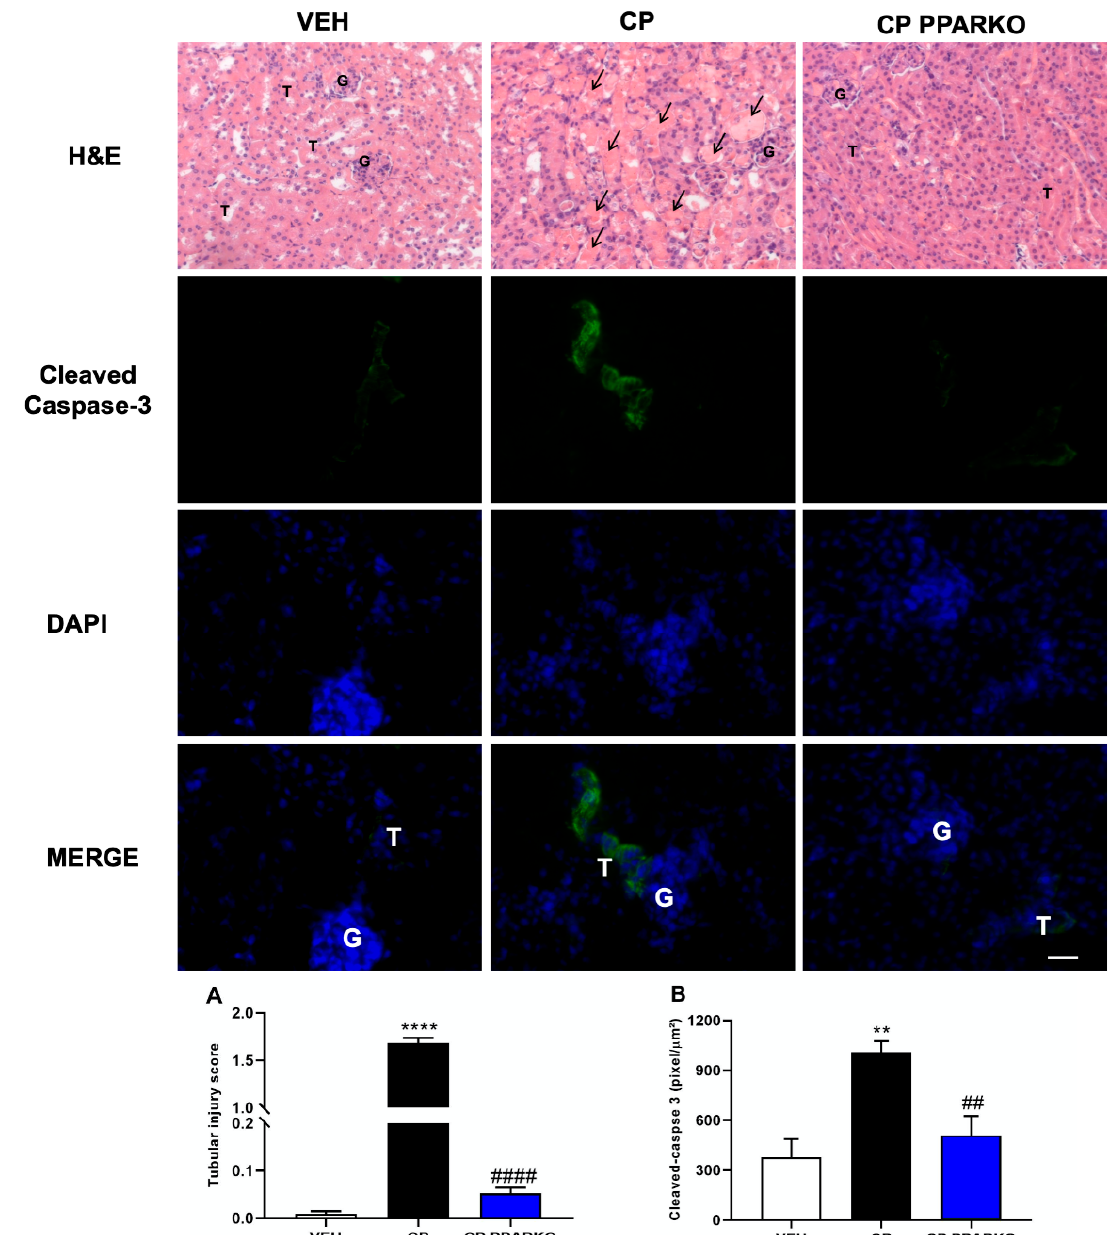
Figure 2. PPAR- α deletion attenuates tubular injury and apoptosis induced by cisplatin after 96 h. Representative photomicrography of H&E staining. ( A ) CP treatment increases tubular injury while PPAR- α deletion attenuates it. ( B ) Immunofluorescence was performed to assess apoptosis. CP increases cleaved caspase-3 staining and CP PPARKO reverses this increase. In arrows is indicated tubules with the tubular lumen obstructed by the tubular casts and cell detachment from the tubular basement membrane. G to indicate glomeruli and a T for examples of tubules with normal structure, no cell detachment and free tubular lumen. n = 5 per group. Scale bar = 100 µ m. One-way ANOVA followed by post hoc Tukey’s test. ** p < 0.01, **** p < 0.0001. compared to the VEH group. ## p < 0.01, #### p < 0.0001; compared to the CP group.